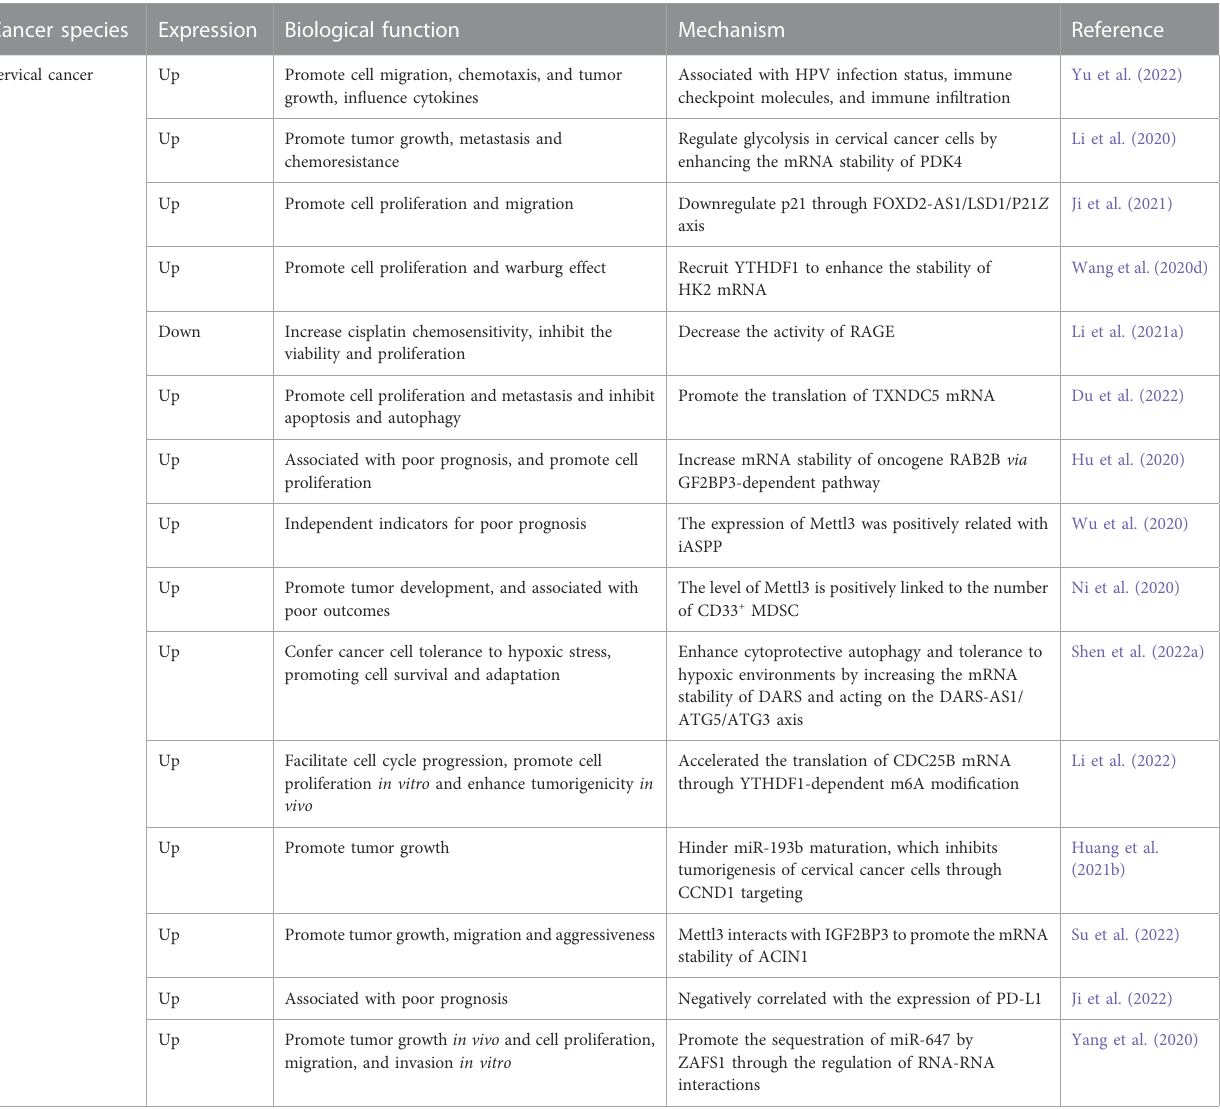
TABLE 1 The role of Mettl3 in cervical